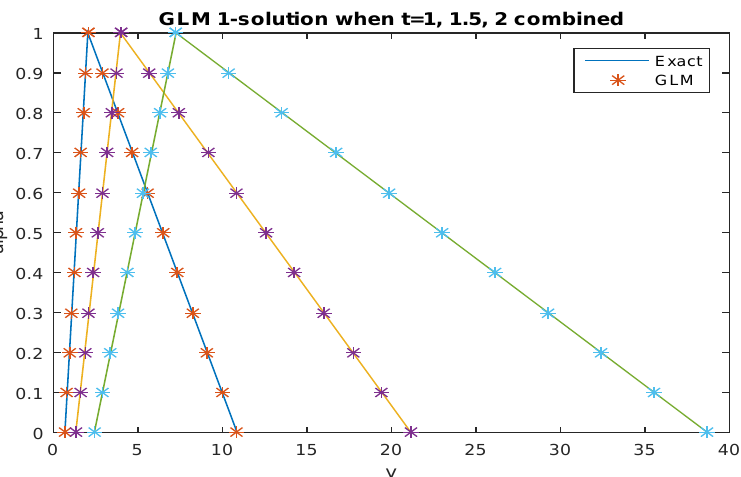
Figure 5. Exact(line) and GLM 2-solutions(stars) for Example 1 when t = 1.0, 1.5 and 2.0 with triangular fuzzy numbers as the initial conditions.